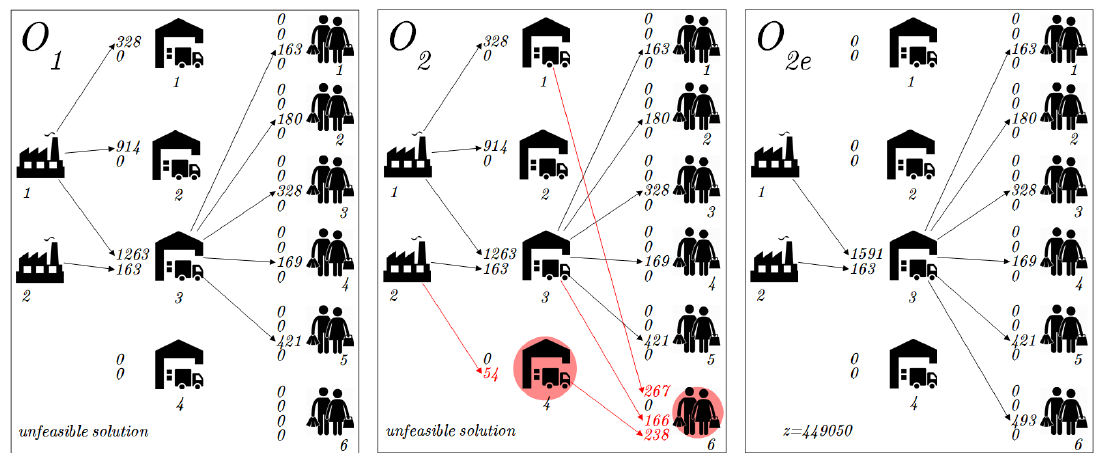
Figure 7. The mutation operator.